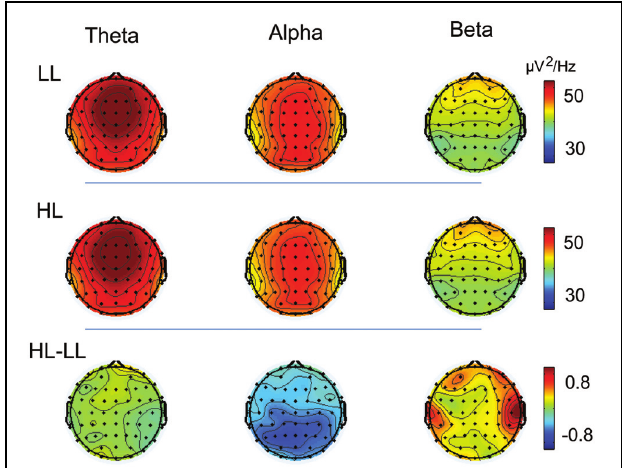
FIGURE 6 | The topographies of theta, alpha, and beta activity in the LL and HL conditions, and the HL minus LL power